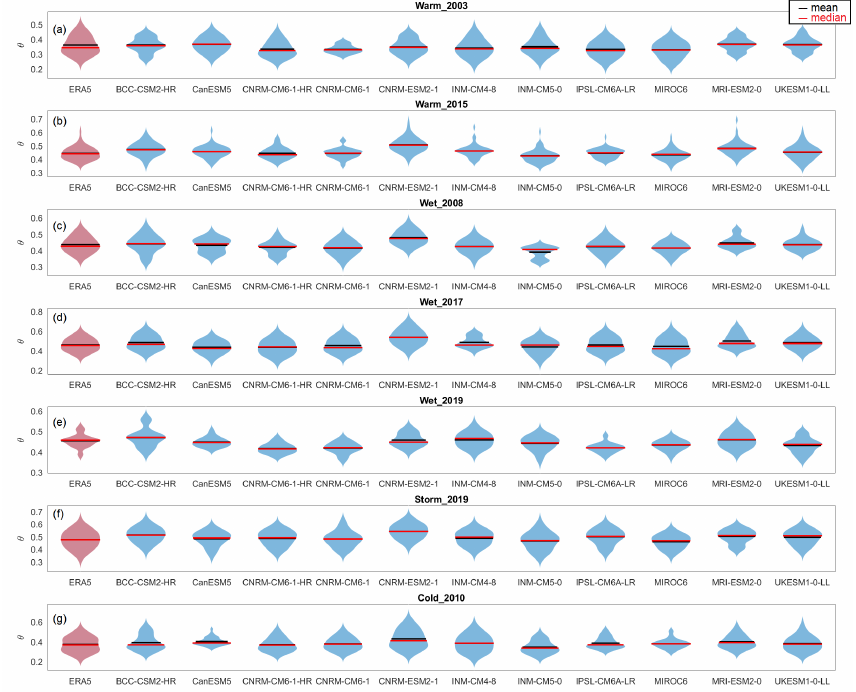
Figure A4. Each row shows violin boxplots of the daily distribution of θ for selected extreme events. The red violins are for the ERA5 reanalysis. The other blue violins are for the 11 CMIP6 models. The horizontal black lines represent the mean. The horizontal red lines represent the